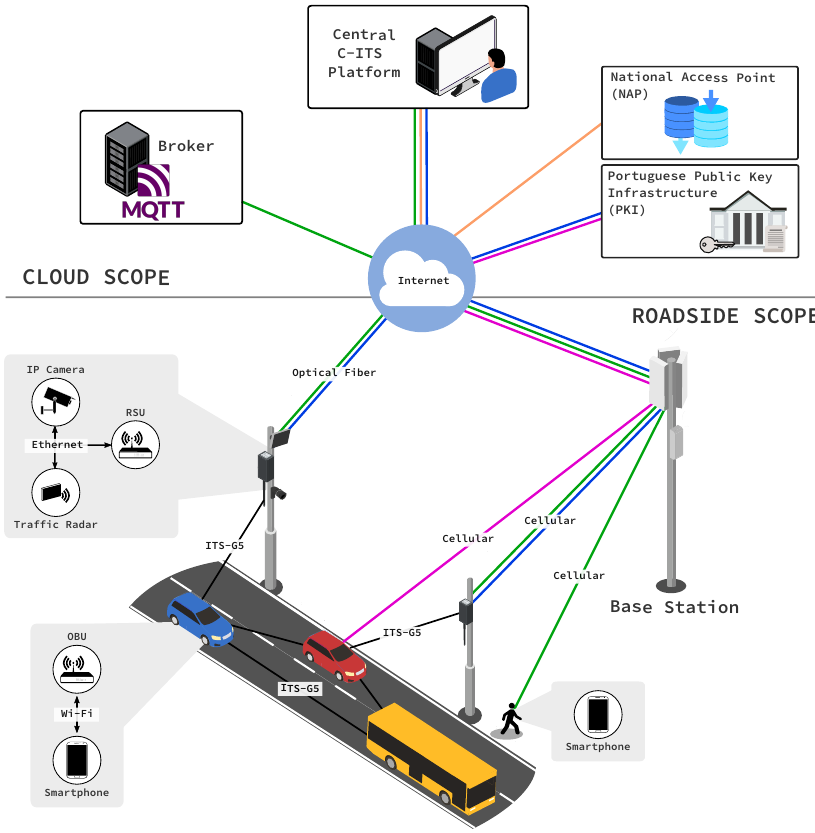
Figure 1. Roadside and cloud-based C-ITS